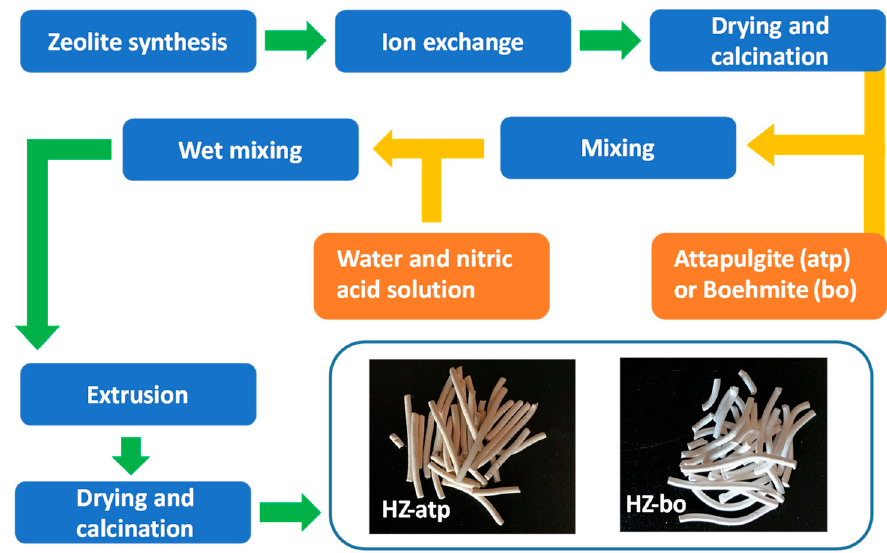
Figure 1. Steps in the preparation of zeolite extrudates with attapulgite and boehmite and key sample photos.